Question: Describe this figure in one sentence.
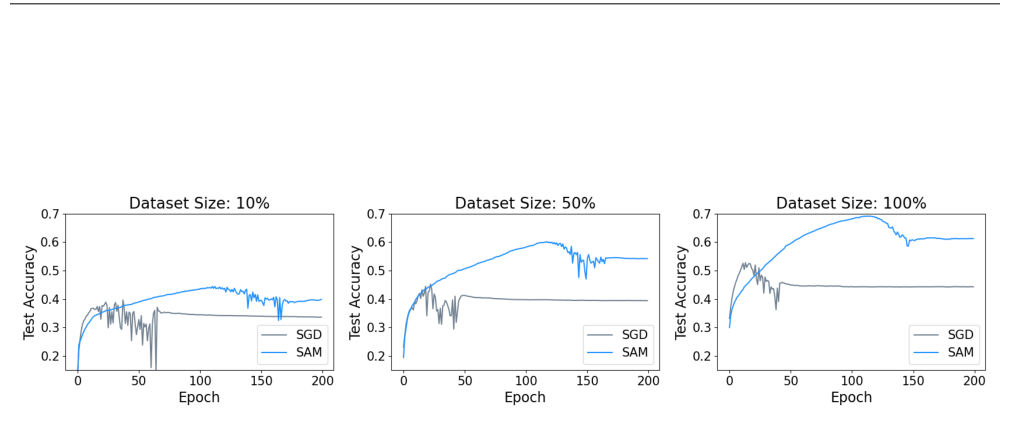
Answer: Behavior with number of training examples for ResNet18/CIFAR10 with 30% label noise We compare SGD and SAM trained on different number of training examples (10, 50, 100% of the training data). We see that the difference between SAM (ρ = 0.01) and SGD increases as the dataset size increases.